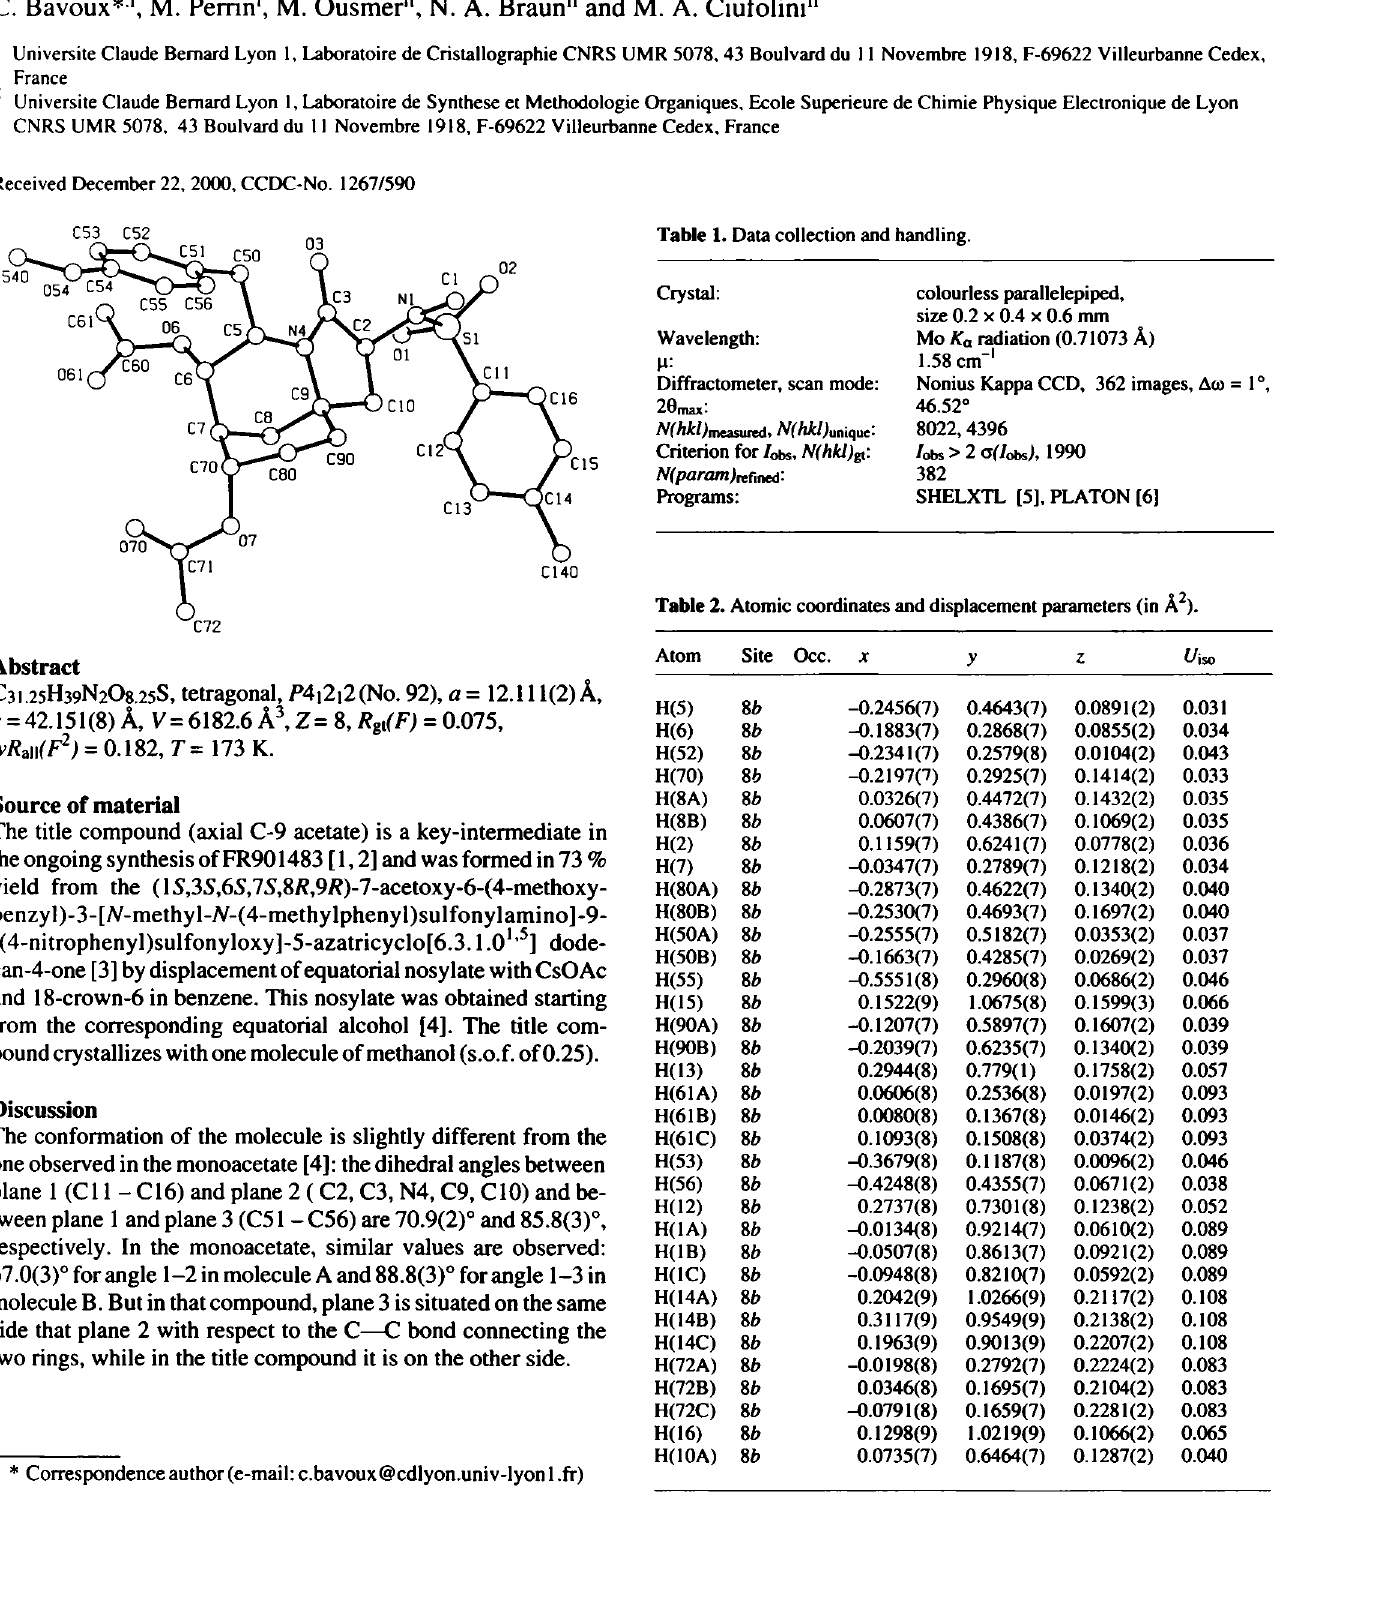
Table 1. Data collection and handling.